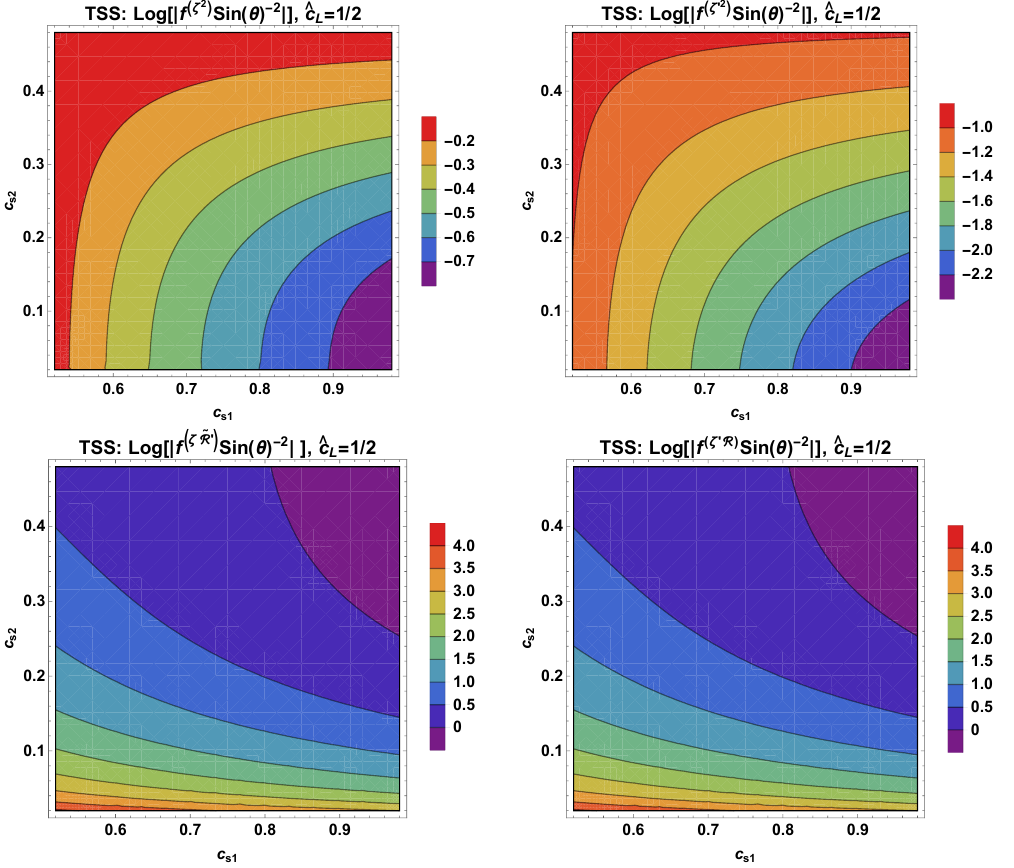
is the dominant one. We set V-B 0